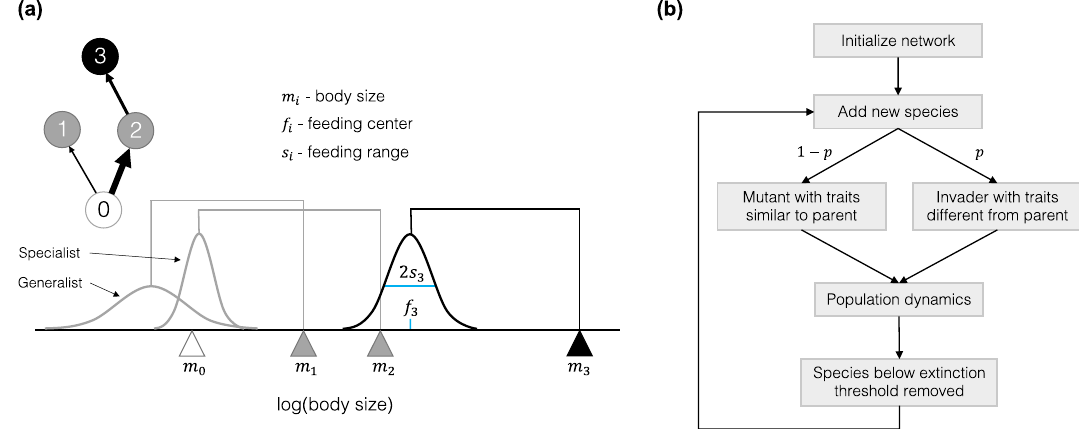
Figure 1. Food web network structure and community assembly process. ( a ) Species traits determine interactions and network structure. Species occupy positions on a body size ( m i ) trait axis, indicated by triangles. Species feeding kernels are illustrated as Gaussian curves, where the center of each kernel is defined by the species feeding center ( f i ) and the peak and breadth of kernels is determined by the species feeding range ( s i ). Species that fall underneath the kernels of other species are consumed by them at a rate proportional to the value of the kernel at that point on the axis. In this example, connections between species are formed given their illustrated body sizes and feeding kernels, and the resulting network structure is shown. Node 0 represents the basal resource pool in the community. Additionally, an example “specialist” and “generalist” species are illustrated, where specialist species have narrower feeding ranges, but larger potential maximum attack rates given the attack rate equation in our model (Eq. (4) in “Methods”). ( b ) Model community assembly occurs through ecological and evolutionary dynamics. Simulations are initialized with a network of two nodes, the ancestor species and the basal resource pool, and initial population dynamics are run. At fixed time intervals new species are added to the network as either mutants or invaders, determined by probability ( p ). The traits of new species are drawn probabilistically from “parent” species that already exist in the network, where mutants are more likely to have traits similar to parents and invaders have a higher probability of having traits different from parents. Between each addition of new species, the consumer-resource dynamics of the network are run, with three potential outcomes: new species go extinct as their population biomass falls below an